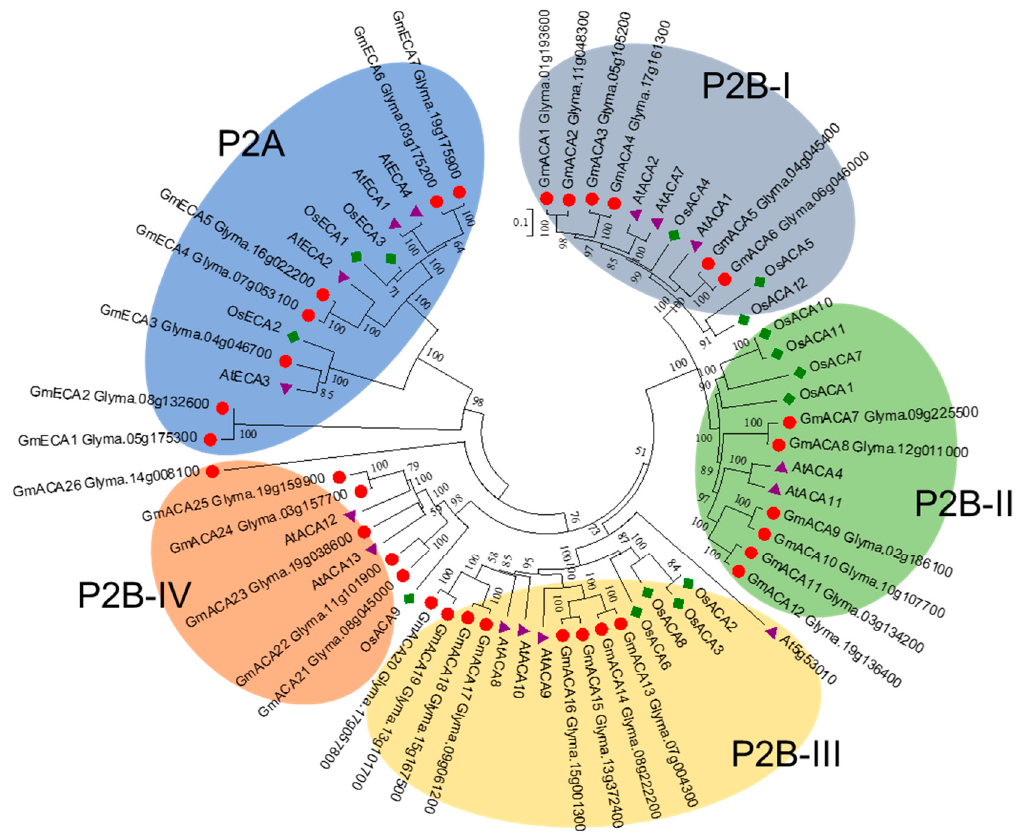
Figure 4. Phylogenetic tree of P2 subfamily proteins from soybean ( Glycine max ), rice ( Oryza sativa ), and Arabidopsis thaliana : the full-length amino acid sequences were aligned by ClustalW. The neighbor-joining phylogenetic tree was constructed by MEGA6 with 1000 bootstrap replications. Soybean genes are denoted by red circles, Arabidopsis genes are denoted by purple triangles, and rice genes are denoted by green diamonds. The locus name of a soybean gene is shown following the gene name. The P2 subfamily is divided into six clades, i.e., P2A, and P2B-I to P2B-IV.